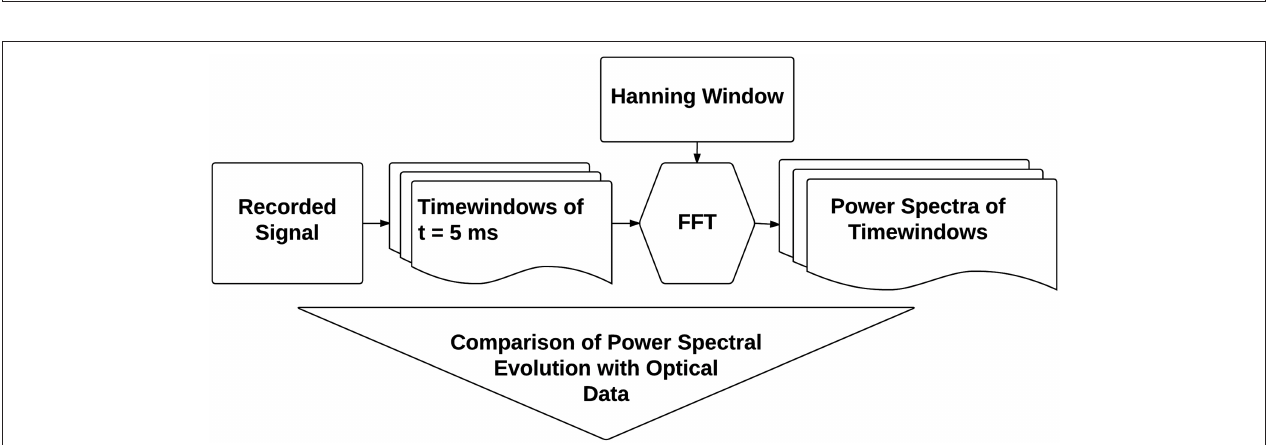
FIGURE 4 | Flowchart showing the acoustic-emission analysis procedure. Snapshots of the experimental signal is taken. Then, they are first converted to the fourier domain to obtain the power spectra. Afterwards, power spectra are compared with each other to understand differences.